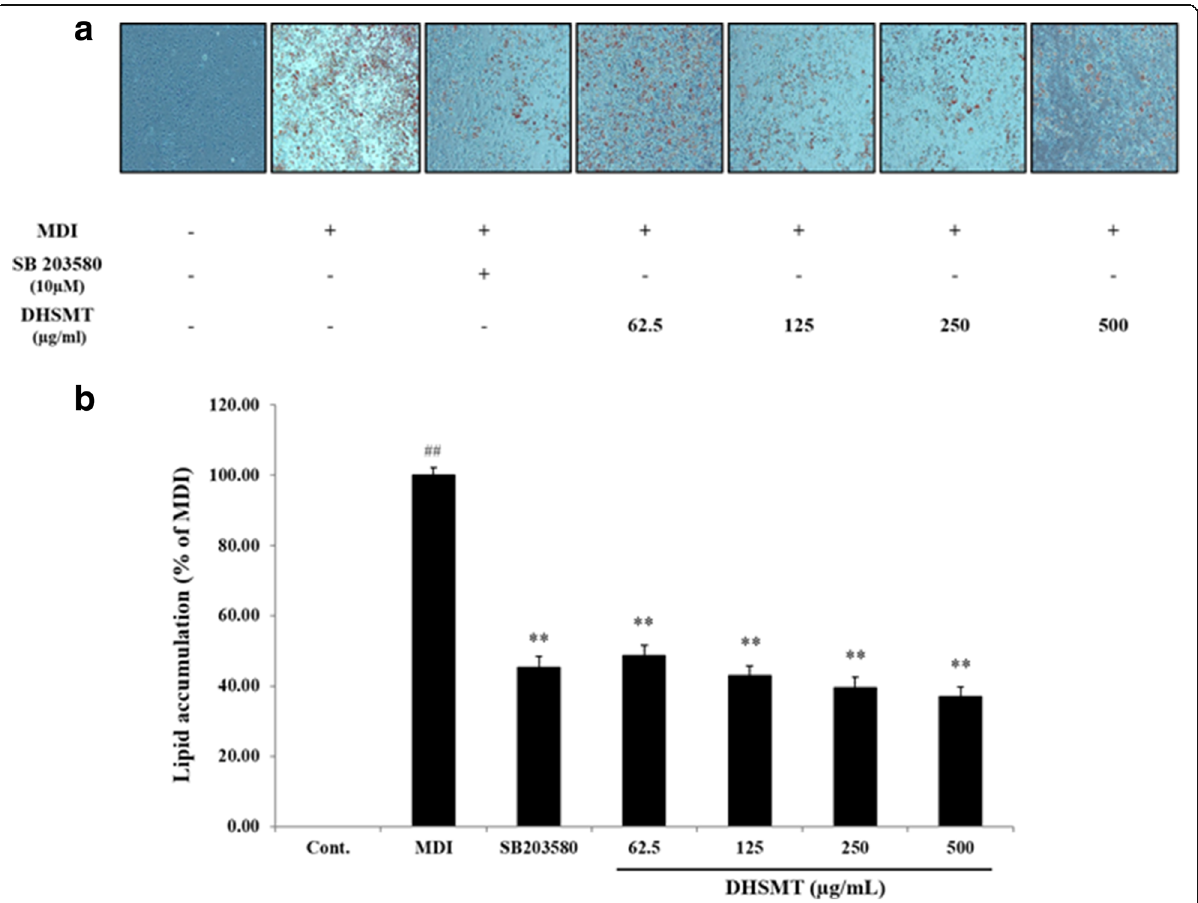
Fig. 3 Inhibitory effect of DHSMT on the lipid accumulation in 3T3-L1 adipocytes during adipogenesis. 3T3-L1 cells were differentiated into adipocytes by incubation with a mixture of 3-isobutyl-1-methylisobutylxanthine, dexamethasone and insulin (MDI) and exposed to various concentrations of DHSMT (0, 62.5, 125, 250 and 500 μ g/ml) and SB203580 for 7 days. a Lipid accumulation in cells were evaluated by Oil red O staining and visualized using microscope at ×100 of magnification. b Stained lipid droplet was dissolved in DMSO and quantified by reading the absorbance at 530 nm. The data are mean values of three experiments ± SEM; ## < 0.01 compared with control, * P < 0.05; ** P < 0.01 compared with the